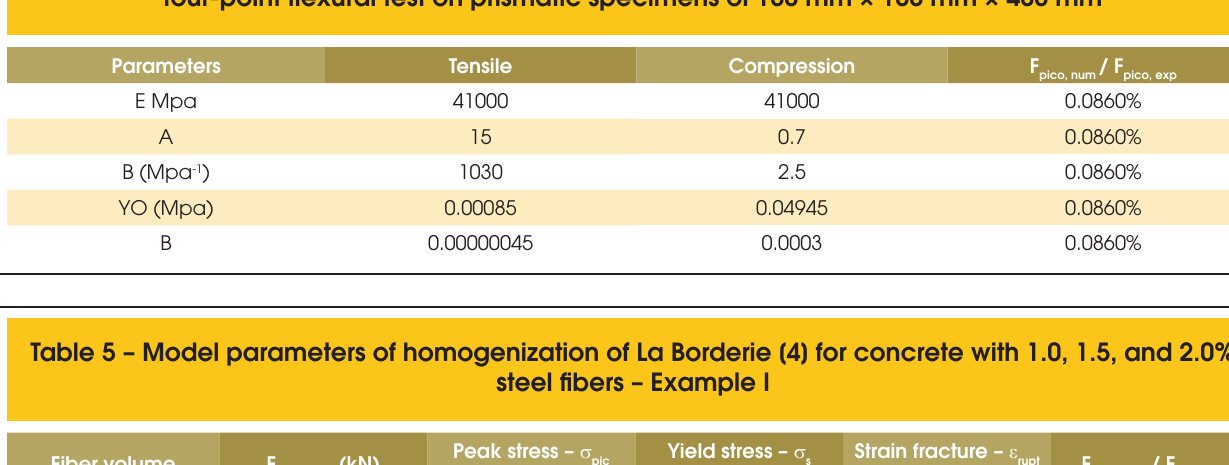
Table 4 – Damage parameters and modulus of elasticity identified for concrete with 0.0% fibers from